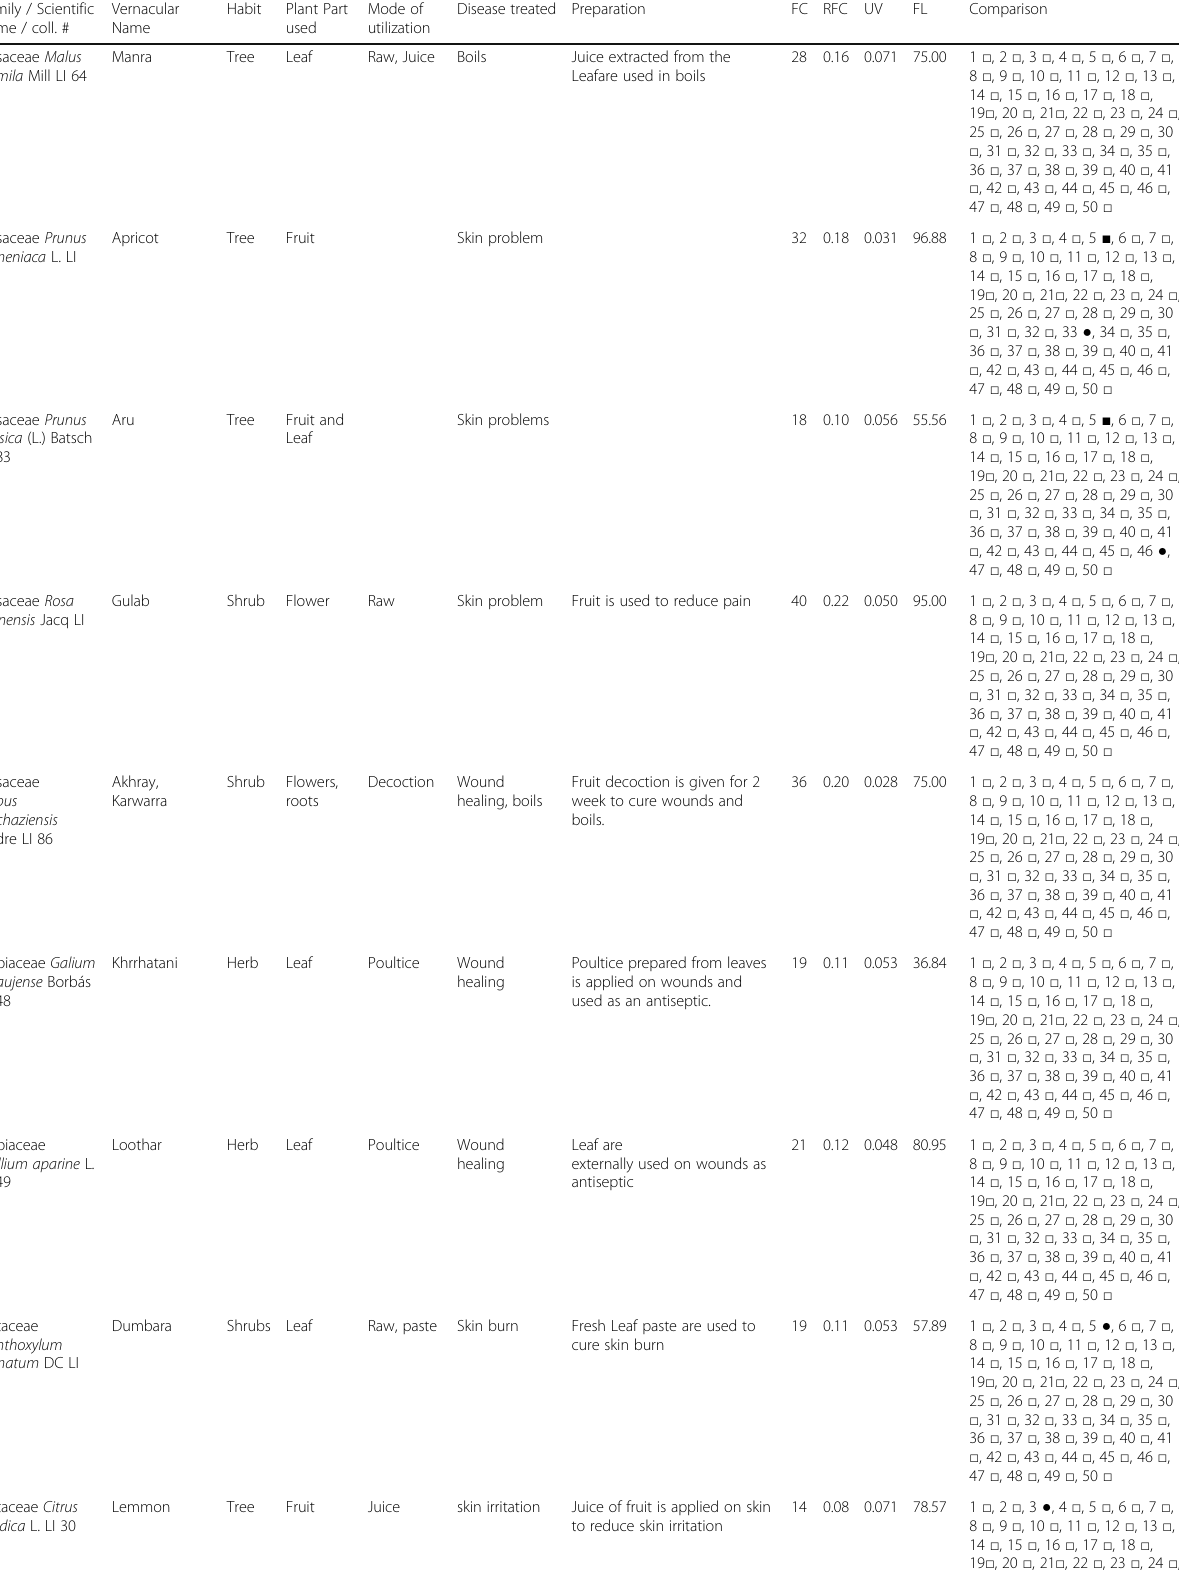
Table 2 Medicinal plants used for skin diseases in Northern Pakistan (Continued) Family / Scientific name / coll.